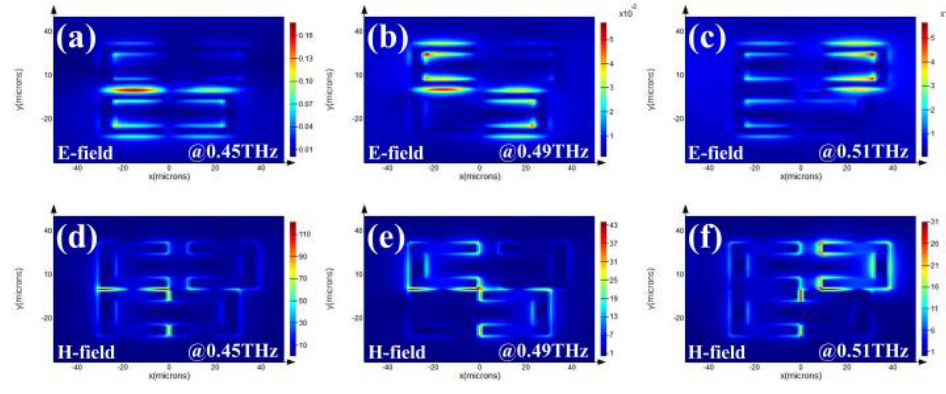
Figure 7. ( a – c ) E-field and ( d – f ) H-field distributions of the RTM device with x 2 = 24 μm in TE mode.